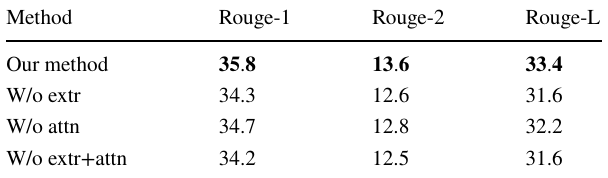
Table 4 Performance comparison of removing the components of our proposed model on the entire CNN/DailyMail test set using full- length F1 variants of Rouge